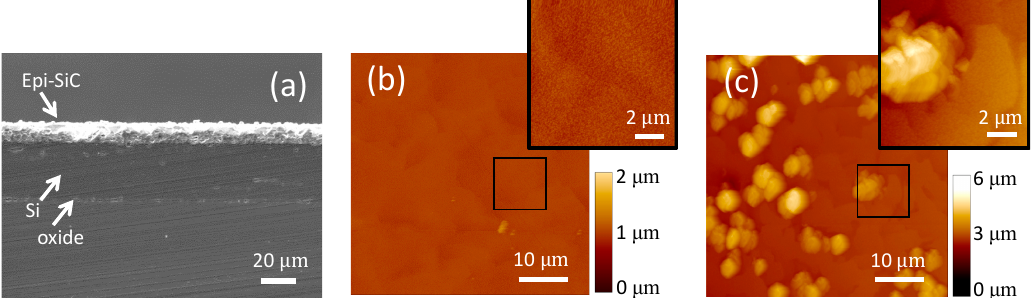
Figure 2. Analysis of epitaxial SiC results. ( a ) Cross-section SEM micrograph of the 3C-SiC epi films on SOI. ( b ) AFM image (tapping mode) of the 3C-SiC epiwafer specular region on the wafer periphery that shows typical 3C-SiC surface morphology (mean roughness of ~ 21 nm). ( c ) AFM image (tapping mode) of the rough surface of the same epiwafer (center) (mean roughness of ~ 244 nm). The devices